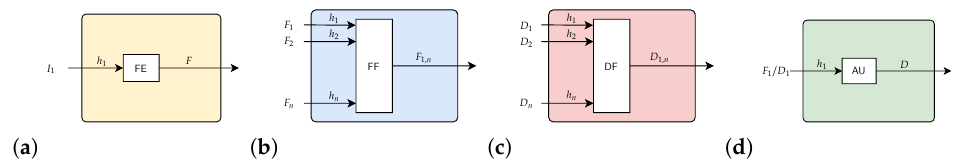
Figure 12. Architectural components used to construct the neural architectures. ( a ) Feature extraction (FE), ( b ) feature fusion (FF), ( c ) decision fusion (DF), and ( d ) analysis unit (AU).